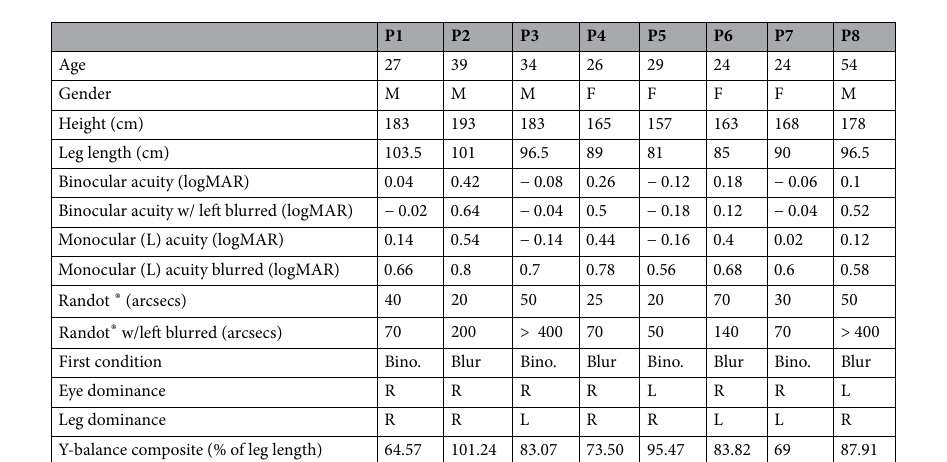
Figure 1. ( a ) A participant wearing the Pupil Labs binocular eye tracker and Motion Shadow motion capture system with the data recording computer on the participant’s back. Optometrist sunglasses were used to shade the eyes to improve eye tracker performance. ( b ) A sample frame from of the data from Supplementary Video 1. On the right is the view of the scene from the head camera, with gaze location indicated by the cross-hair. Below are the horizontal and vertical eye-in-head records. The high velocity regions (steep upward slope) show the saccades to the next fixation point, and the lower velocity segments (shallow downward slope) show the slower eye movement that stabilizes gaze on a particular location in the scene as the participant moves towards it, resulting a characteristic saw-tooth appearance for the eye signal. On the left, the stick figure shows the skeleton figure reconstructed from the Motion Shadow data. This is integrated with the eye signal which is shown by the blue and pink lines. Gaze location history is indicated by the Gaussian heat maps. The blue and red dots show the foot plants recorded by the motion capture system.